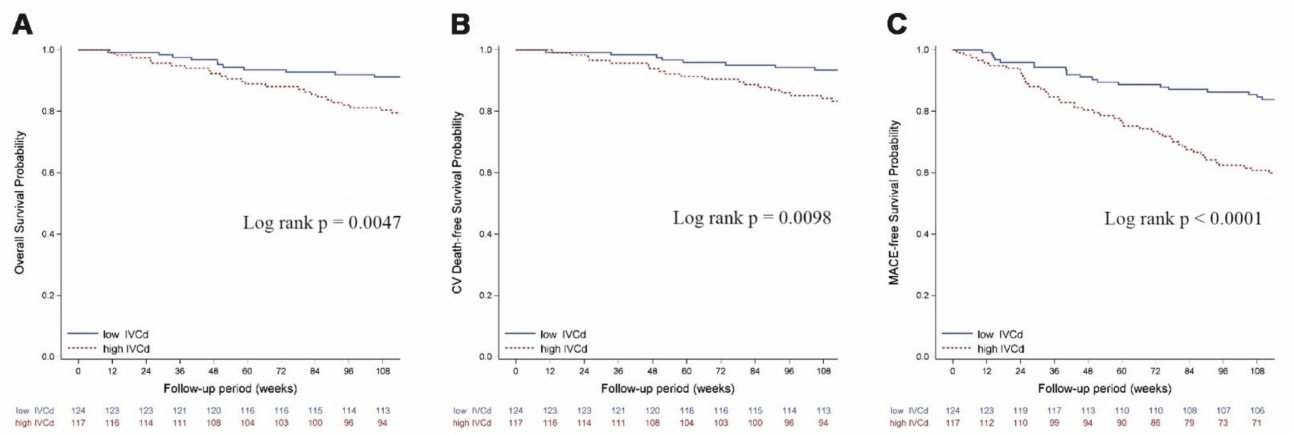
Figure 2. Survival curve for ( A ) all-cause mortality, ( B ) CV mortality, and ( C ) MACE-free events between chronic HD patients in high- and low-IVCD